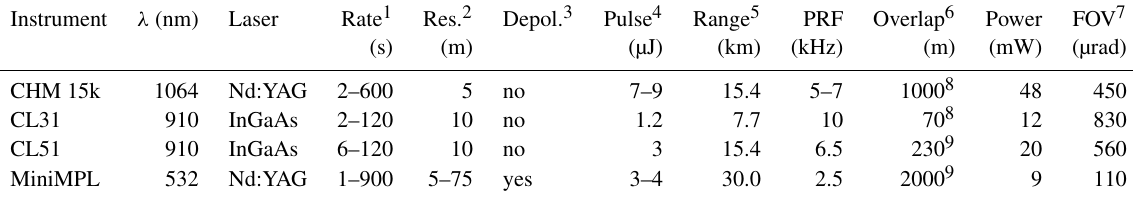
Table 1. Table of ALCs and their technical parameters. Power is calculated as pulse × pulse repetition frequency (PRF). Instrument λ (nm) Laser Rate 1 Res. 2 Depol. 3 Pulse 4 Range 5 PRF (s) (m) (µJ) (km) CHM 15k 1064 Nd:YAG 2–600 CL31 910 InGaAs 2–120 CL51 910 InGaAs MiniMPL 532